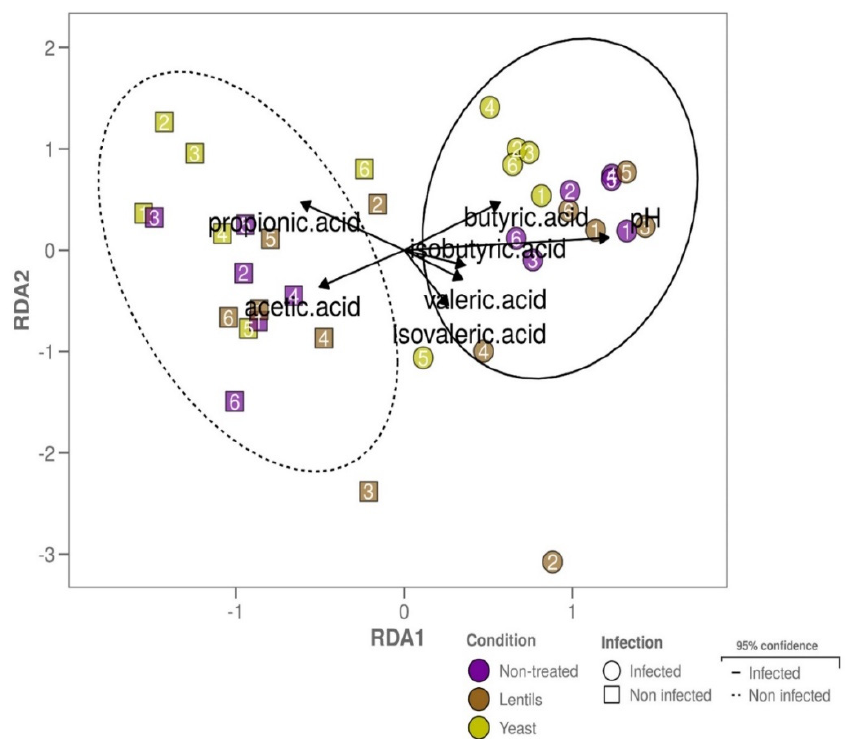
Figure 12. Distance-based redundancy analysis modeling of the microbiota community structure according to pH and SCFA production. The two-dimensional plot reports the β -diversity structure of the whole microbial community taxonomy at the end of the experiment (T 24 ) at the ASV level in the luminal phase according to db-RDA and explained by metabolite variables (SCFAs and pH). Individual samples are represented by dot shapes and square shapes for the infected and non-infected conditions, respectively. The 95% confidence ellipse zone is also indicated in a continuous line for the infected condition and in a dotted line for the non-infected conditions. The donor number is indicated for each sample.